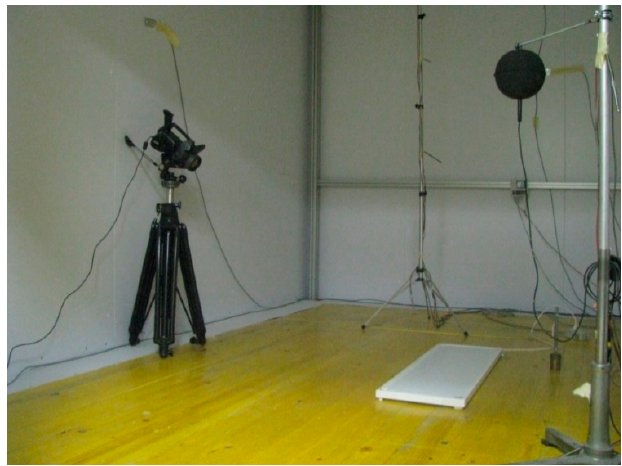
Figure 3. Experimental setup with the radiant panel, the air temperature probes, and the thermal camera.